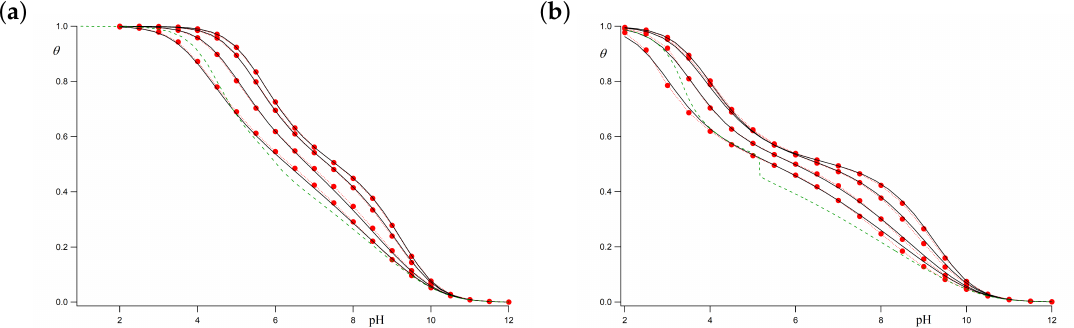
Figure 5. Titrations curve for the model polyelectrolyte depicted in Figure 2 with p K = 9 , (cid:101) t = 1, u g = 0 (i.e., (cid:101) g → ∞ ) and σ = 1 ( a ) ; σ = 10 ( b ). The chosen ionic strengths are, from top to bottom, 1 M, 0.1 M, 0.01 M and 0.001 M. Black continuous lines represent calculations using the LEIP method in which two effective short-range parameters (p K and p σ ) has been corrected. Red circles depict the MC values. The green dashed line corresponds to the LEIP values for I = 0.001 M when only the p K -value is corrected, while p σ is kept